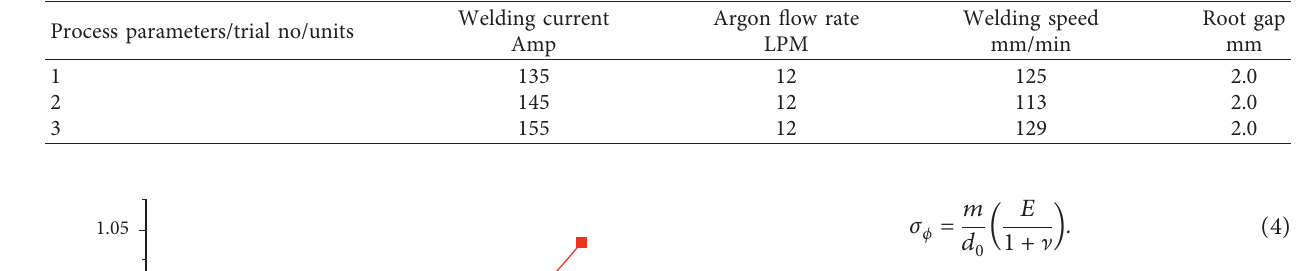
Table 2: Process parameters and their